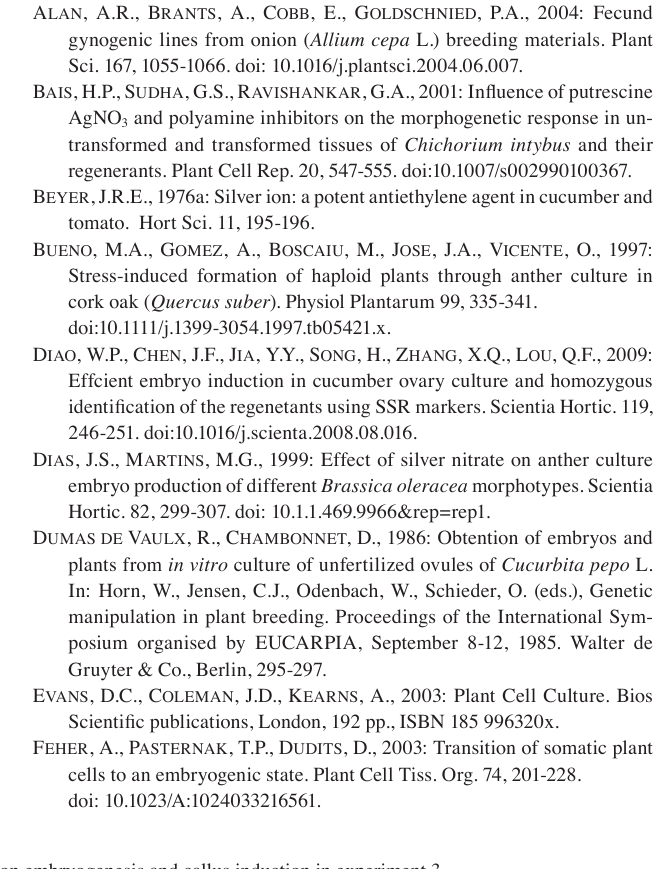
Tab. 7: Interaction effects of different hormonal combinations and genotype on embryogenesis and callus induction in experiment 3. Growth